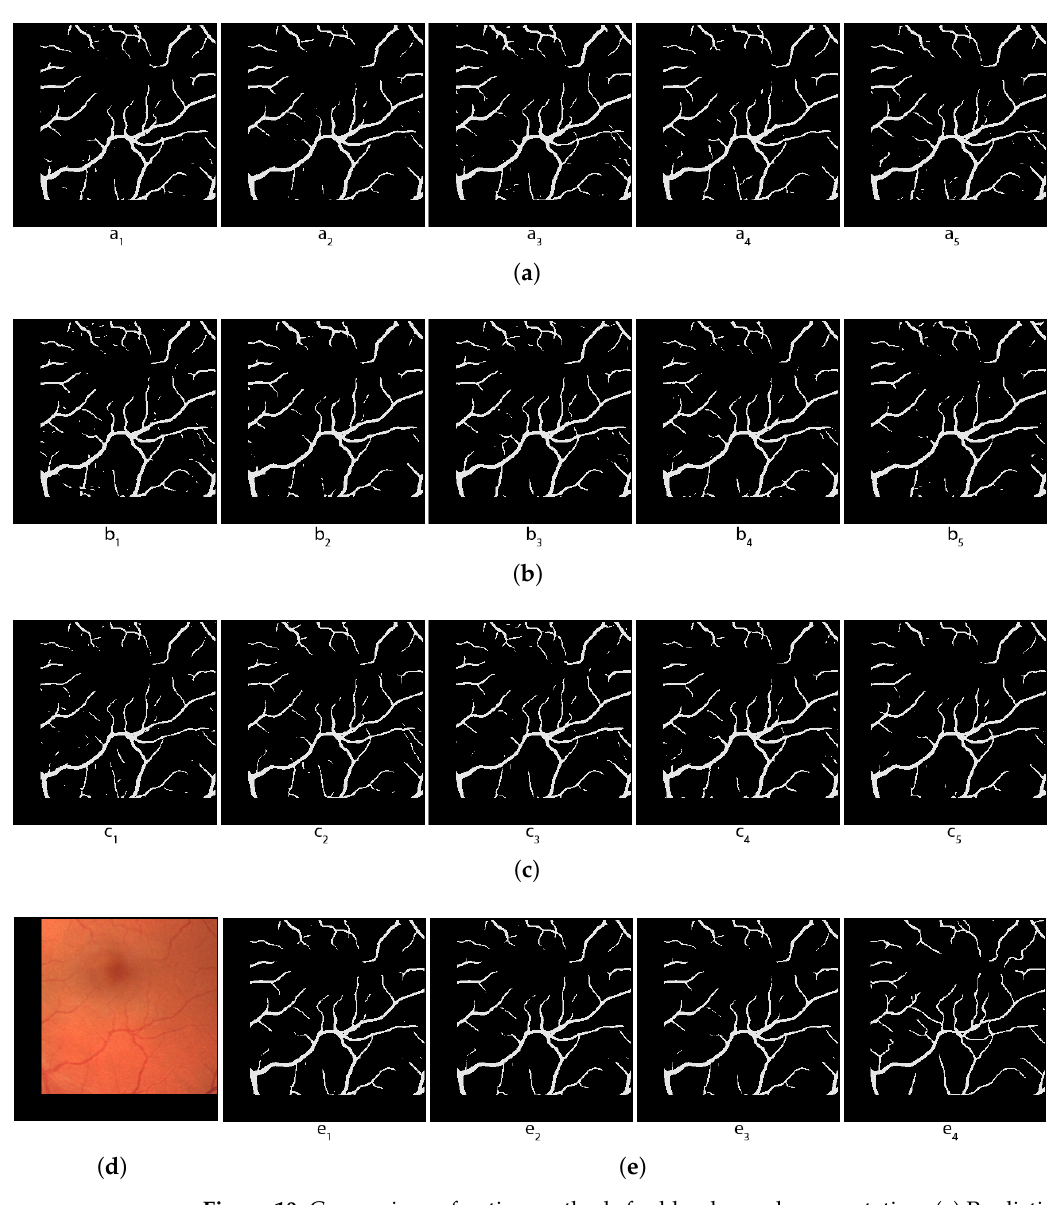
Figure 10. Comparison of voting methods for blood vessel segmentation. ( a ) Predictions of the first 5 folds; ( b ) Predictions of the second 5 folds; ( c ) Predictions of the last 5 folds; ( d ) Original image; ( e ) e 1 : Local topological voting with s = 10, e 2 : Hybrid voting ( s = 10, threshold = 2), e 3 : Arithmetical voting, e 4 : True Mask.